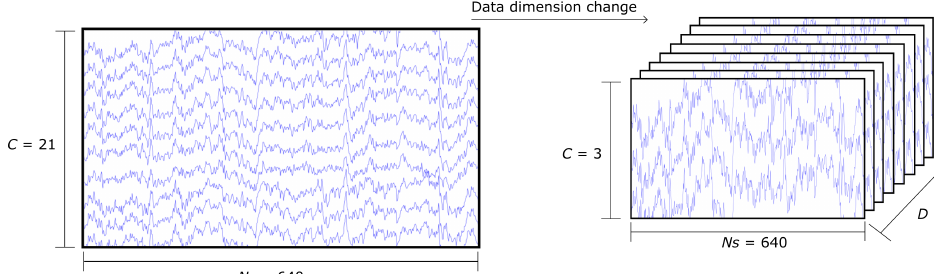
Figure 8. The 21-channel raw EEG signal data preparation for volume representation, where C indicates the number of channels, Ns indicates the number of samples per channel, and D indicates the number of depth layers in the 3D matrix of the volume representation.